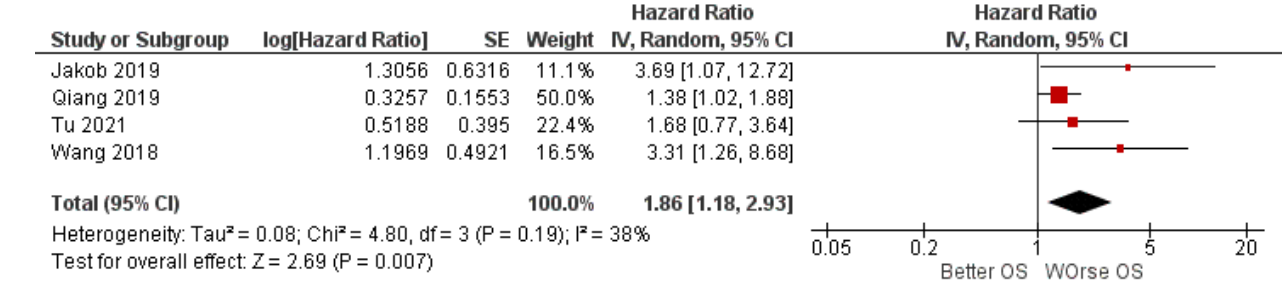
Figure 4. Forest plot of the random-effects model of the meta-analysis.